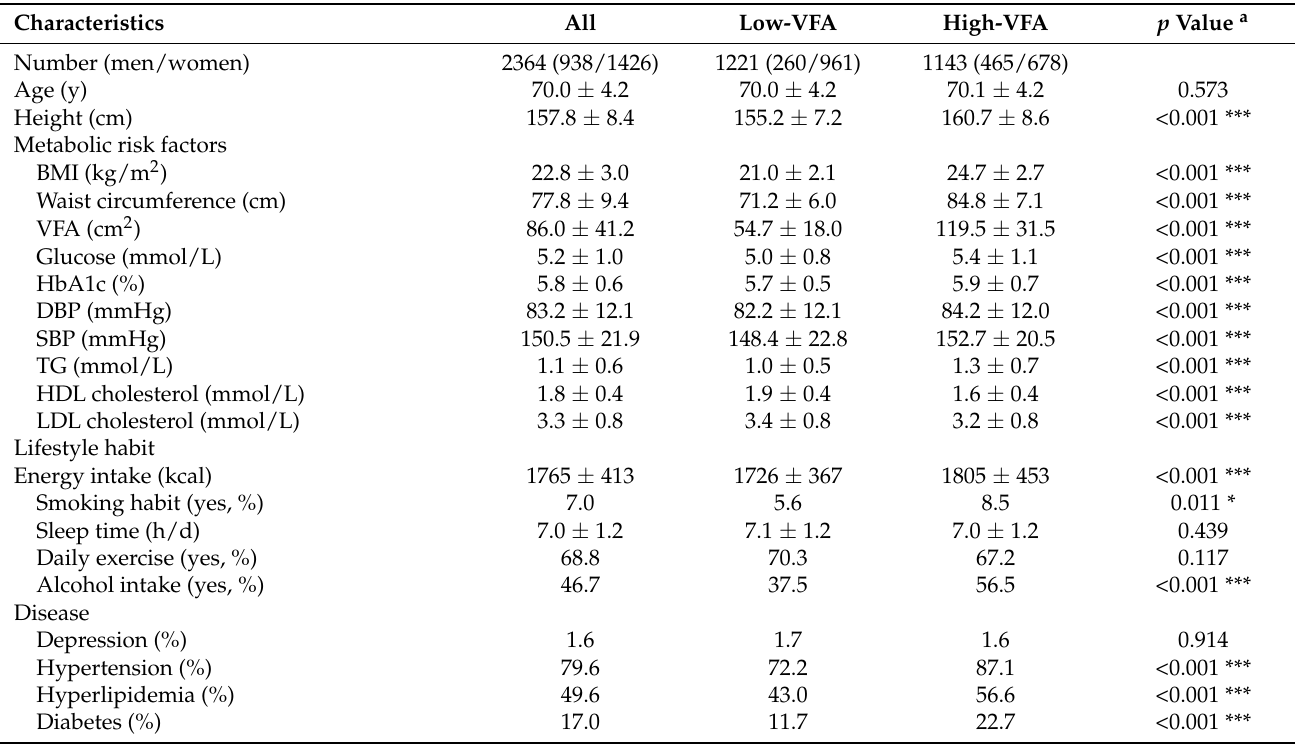
Table 2. Characteristics of the study participants according to